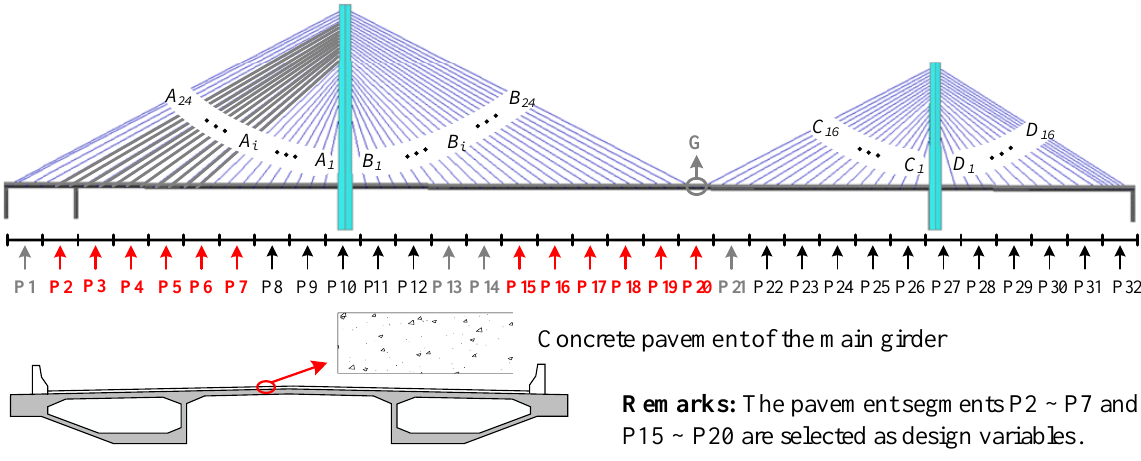
Figure 14. Design variables and random variables.